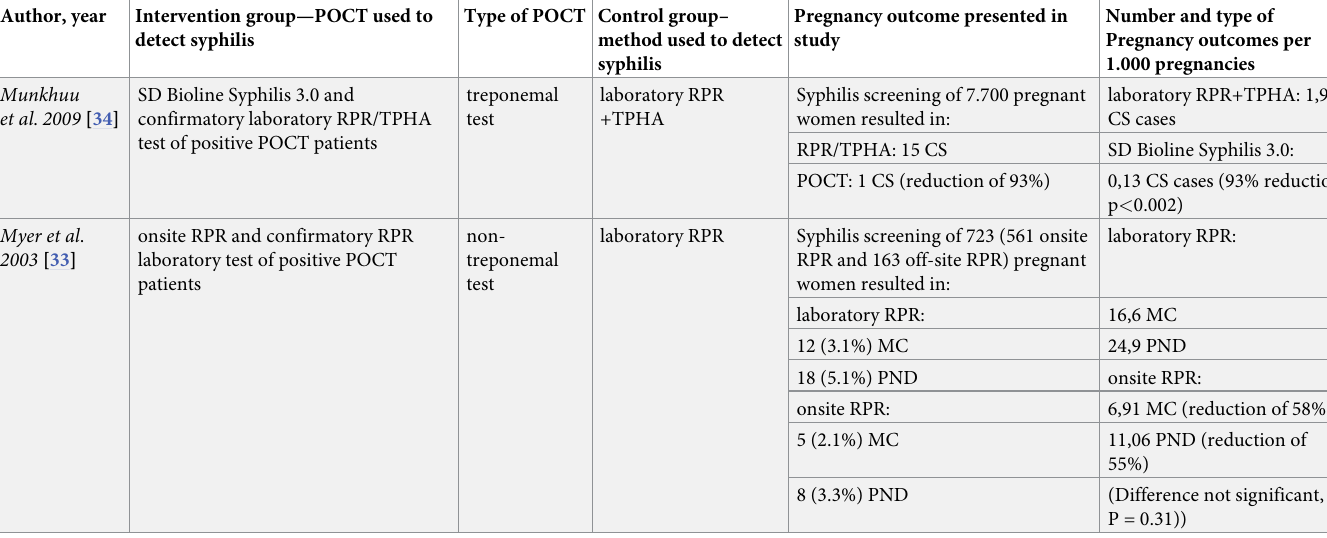
Table 2. Association between syphilis POCTs and pregnancy outcomes in clinical